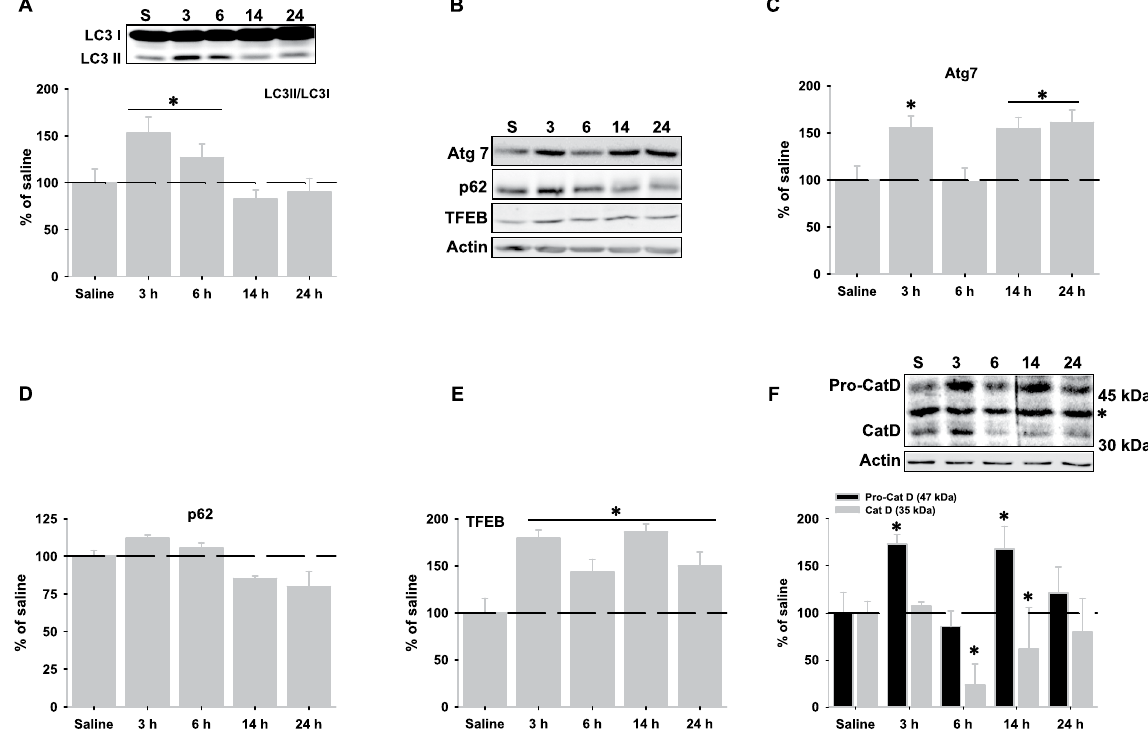
Figure 1. LPS injection induces transient autophagy activation in rat hippocampus. ( A ) Representative western blot of LC3 I and II and graphical representation of quantification of the LC3 II/LC3 I ratio determined by optical density at different times after LPS injection. ( B ) Representative western blots of Atg7, TFEB and p62 at different times after LPS injection. ( C – E ) Graphical representation of data from optical density quantification of western blots corresponding to Atg7, TFEB and p62, respectively. ( F ) Representative western blot and graphical representation of quantification by optical density of lysosomal protease cathepsin D at different times after LPS injection. The asterisk indicates a non-specific band. Data are presented as mean ± SD (n = 4) of percentage of variation relative to controls. * p < 0.05, significant differences compared with control (saline-injected)